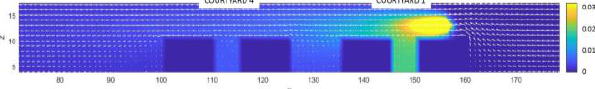
Fig. 3. Vertical field of nondimensional CO concentration C/C 0 at the middle section of courtyards 1 and 4 (wind comes from the